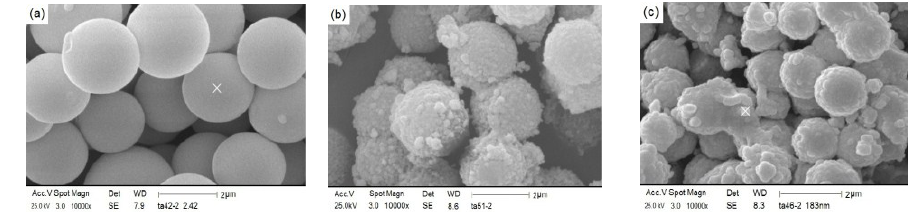
Figure 4. Particles synthesized in presence of different acid ratios: a) ratio= 4, b) ratio= 10, c) ratio= 20.